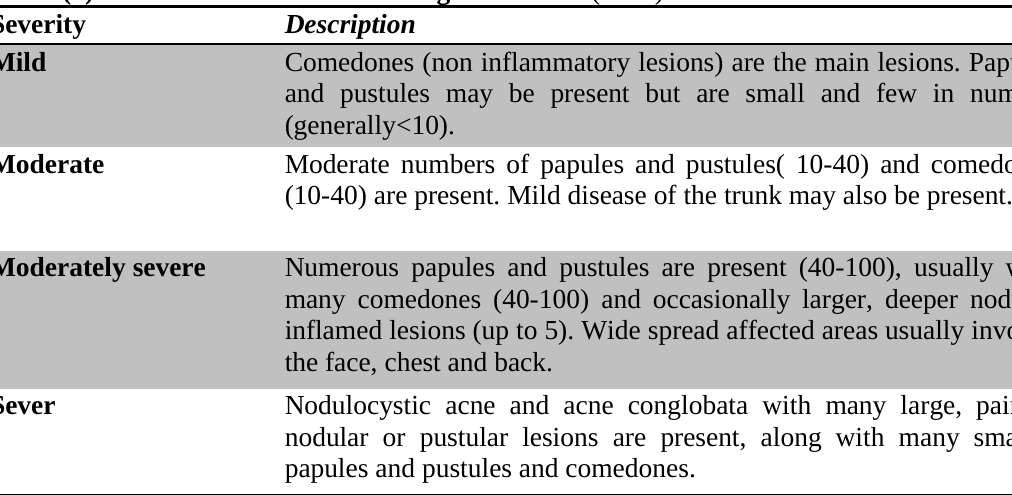
Table (2): Acne classification according to Cunliffe (2003) (49)